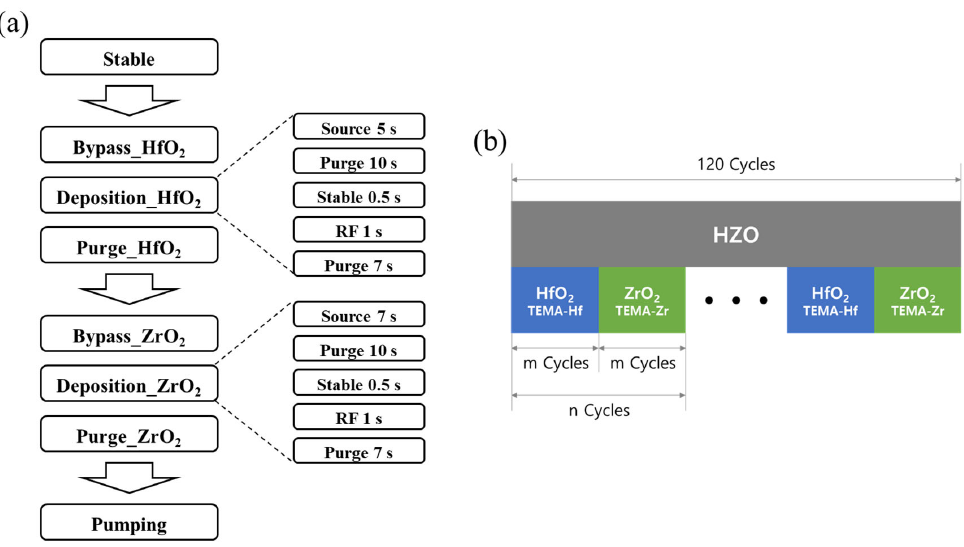
Figure 2. Schematic of ( a ) ALD deposition process ( b ) HZO thin film deposition.